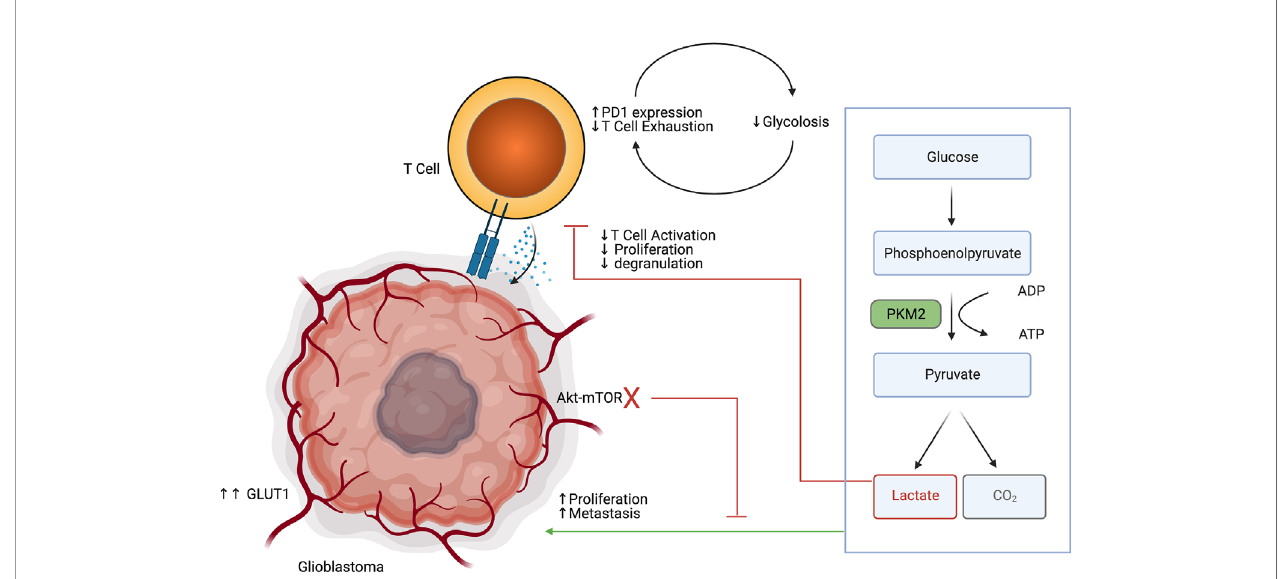
FIGURE 2 | Glioblastoma glycolysis drives tumor progression while inhibiting T cell glycolysis, activation, proliferation and